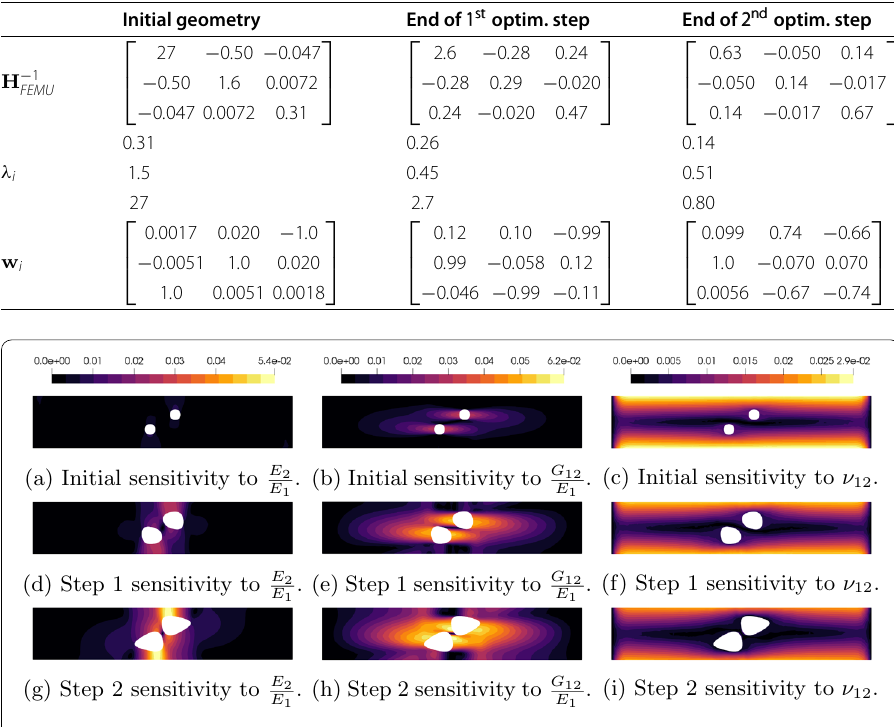
Fig. 17 Sensitivity fields magnitude for each constitutive parameter, initially and at each optimization